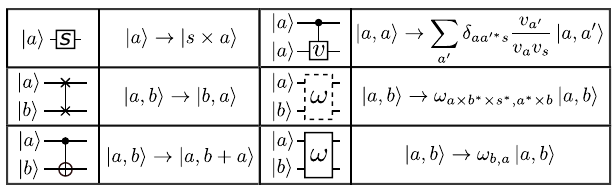
FIG. 15. The definition for the qudit gates used in the con- struction of the open-string operators, where s is the label for the corresponding simple string operator. The quantity ω p (cid:10) , p is = p (cid:10) and i = p , and the orien- the phase ω k in Eq. (A9), with i (cid:10) k k tation is to be identified from the direction of the string operators in the circuit diagrams, such as in Figs. 13 and 14.